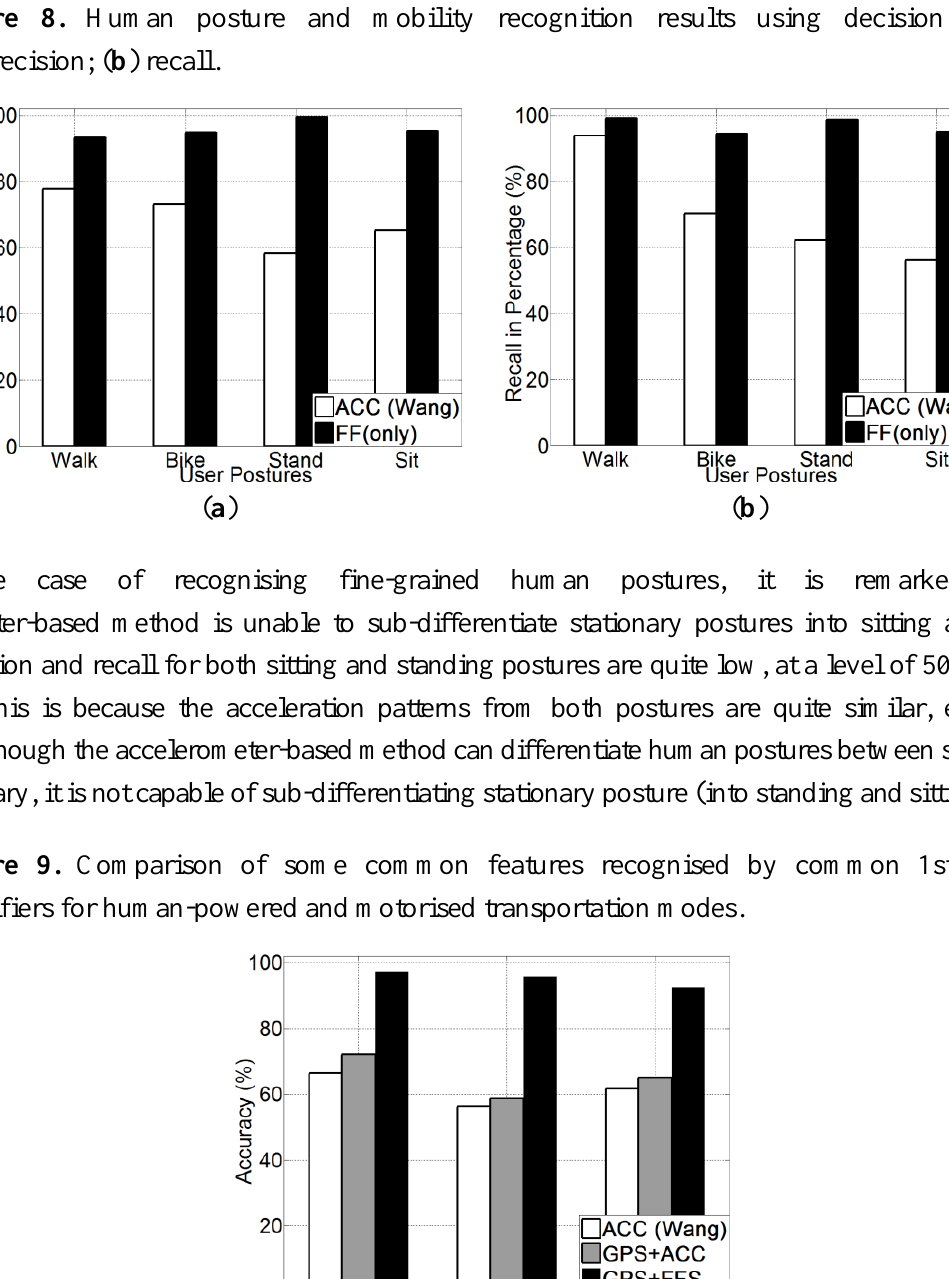
Figure 8. Human posture and mobility recognition results using decision table: